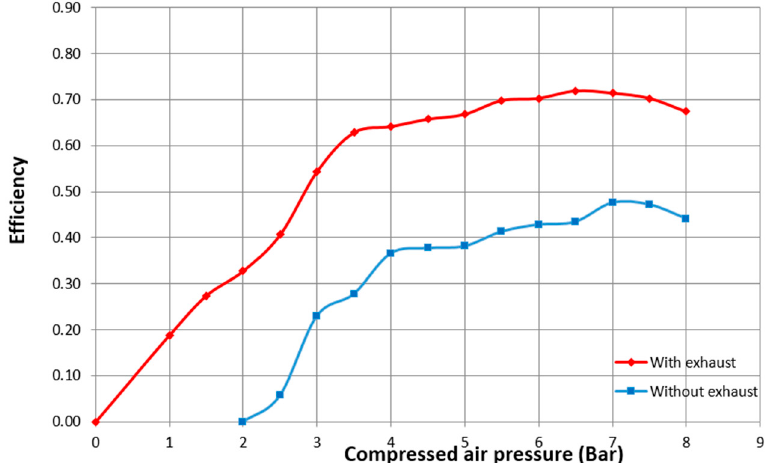
Figure 9. Relationship between efficiency of air motor and inlet pressure for the with and without exhaust cases.